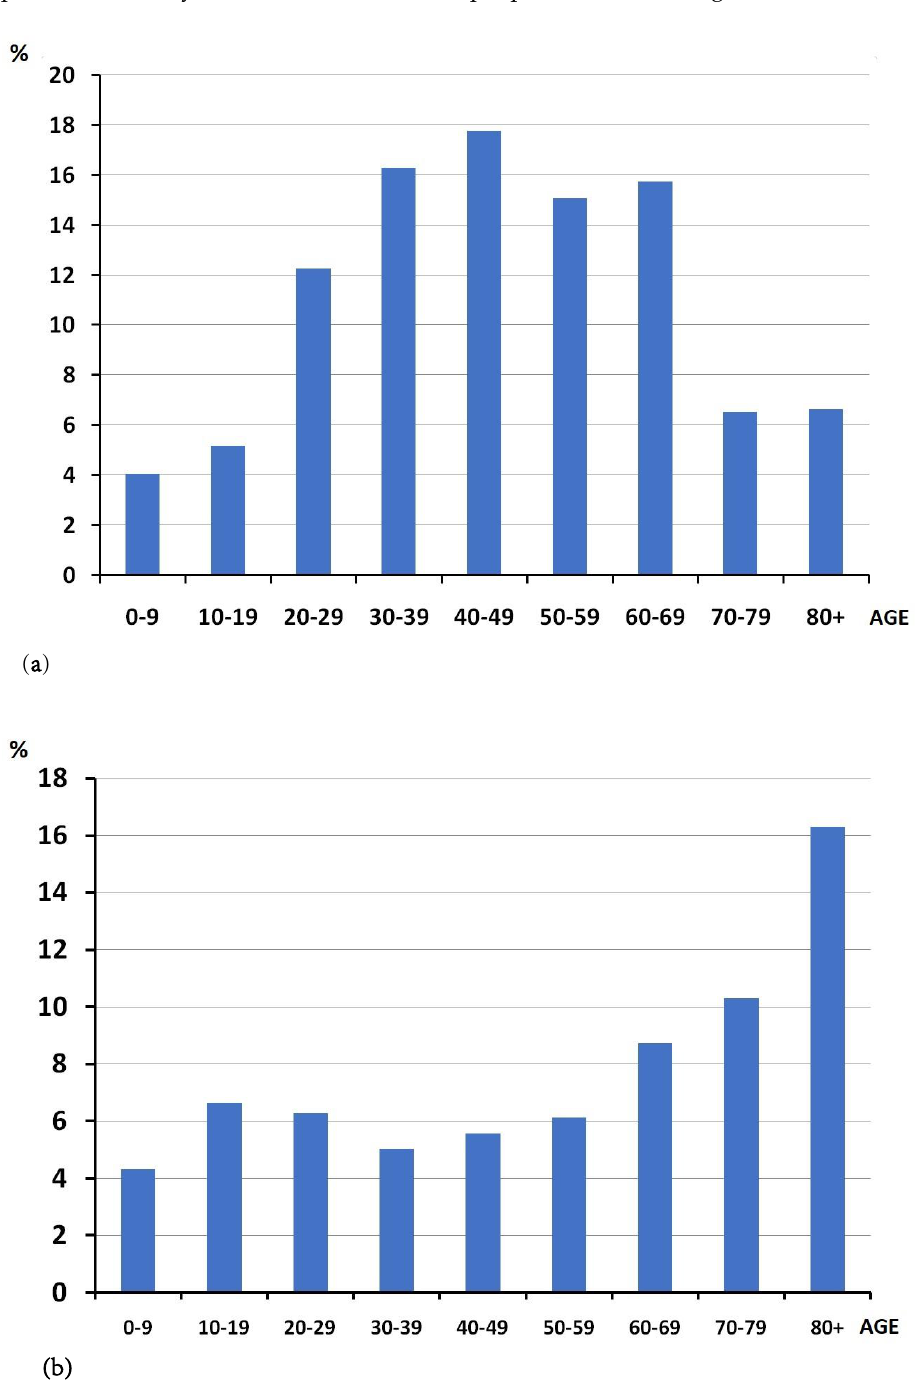
Figure 1. The percentage of positive cases per age group: ( a ) expressed as a percentage of the total number of positive cases; ( b ) expressed as a percentage of the total number of tested people of each corresponding age group. ( a ) the percentage of positive cases in each age group of the total number of positive cases. ( b ) the percentage of positive cases in each age group of the total number of tested people of each corresponding age